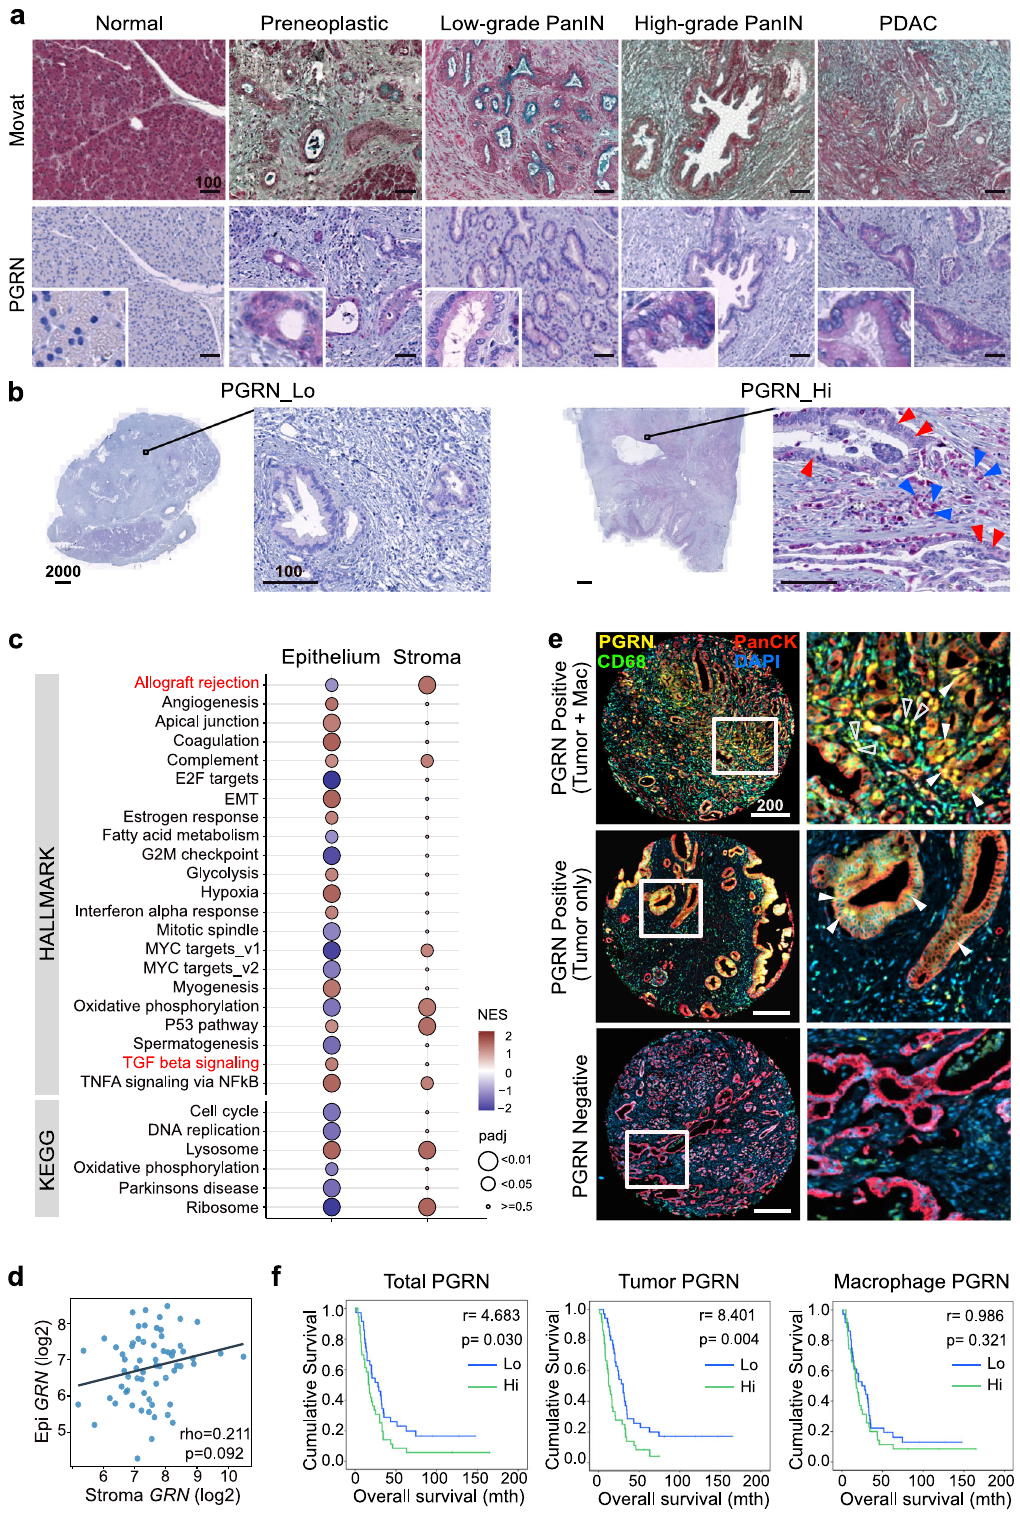
levels (Supplementary Fig. 2a), were selected for GRN suppression (Supplementary Fig. 2b, c). Note that MiaPaCa2 and PaTu8988T showed relatively low surface but high intracellular MHCI expression levels (Supplementary Fig. 2d). Surface expression of MHCI on cells of both cell lines was signi fi cantly augmented upon RNAi-mediated knockdown of GRN (Fig. 3a, Supplemen- tary Fig. 3a). MHCII was also examined and there was no